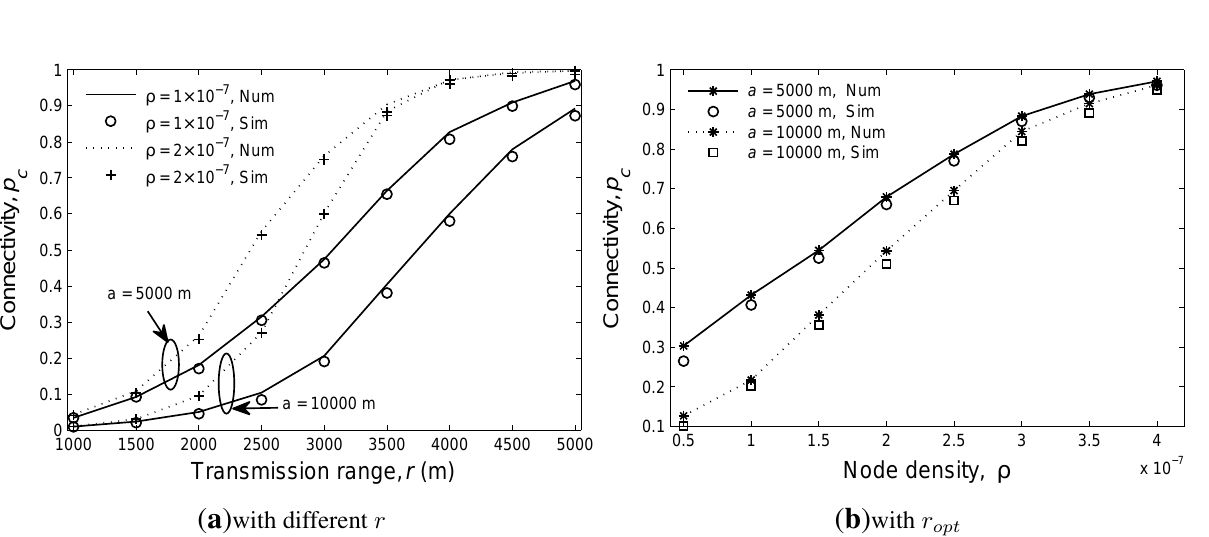
Figure 6. The results of the network connectivity with different transmission ranges ( a ) and with optimal transmission ranges ( b